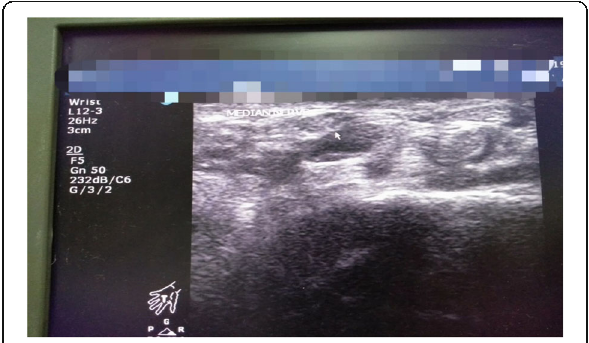
Fig. 3 Ultrasound probe on the medial aspect of wrist at the median nerve